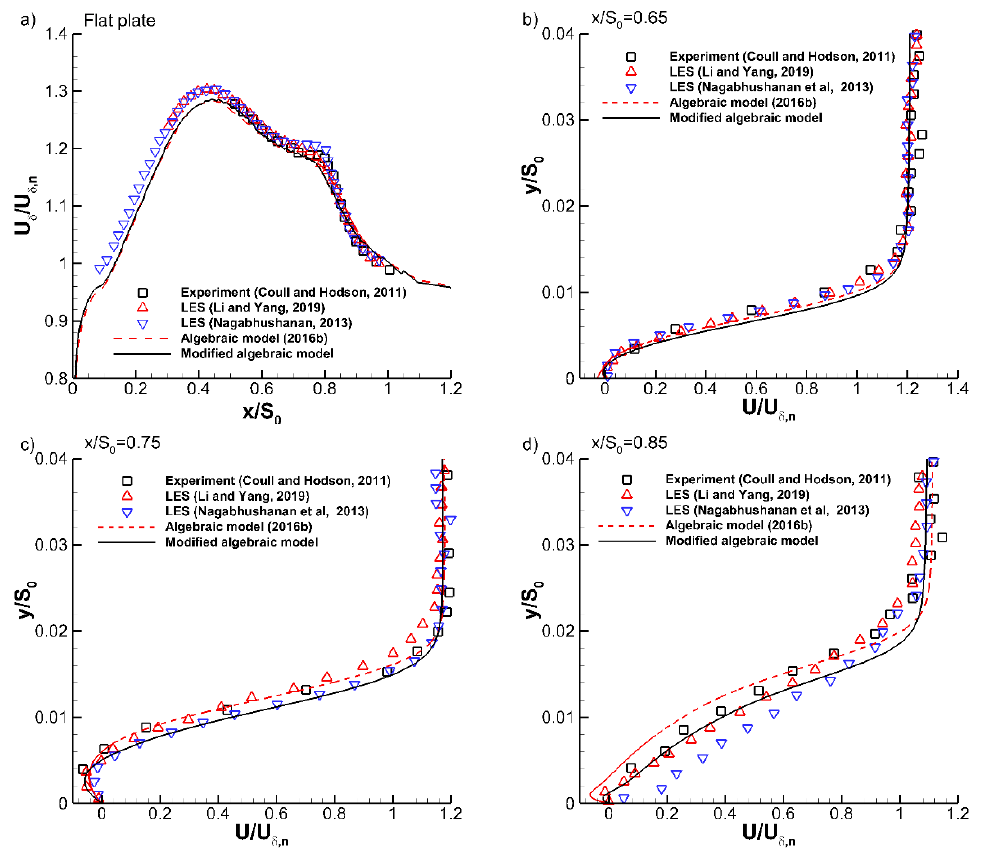
Figure 8. Flat plate by Li and Yang. ( a ) mean velocity at the boundary layer edge and mean x-velocity profiles at streamwise distances: ( b ) x/S 0 = 0.65, ( c ) x/S 0 = 0.75, and ( d ) x/S 0 = 0.85. LES: large eddy simulation.